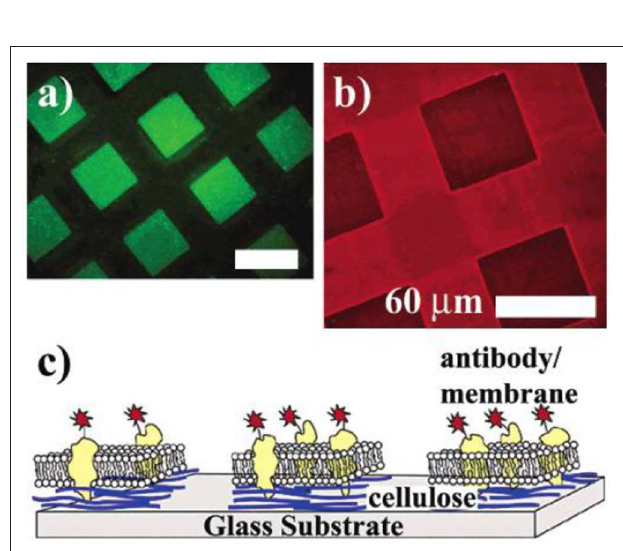
FIGURE 6 | (a) Fluorescence image of cellulose micropatterns exposed to a solution of bovine serum albumin labeled with fluorescein isothiocyanate (FITC-BSA) after removing the photomask. FITC-BSA adsorbs only onto the ablated area (bare glass substrate). (b) Human erythrocyte membranes spread on cellulose microtemplates (without BSA treatment). After incubation, the cytoplasmic domain of Band 3 is identified with a monoclonal and a TRITC-labeled polyclonal antibody (inside label). (c) Orientation of the erythrocyte membrane after spreading. Erythrocyte ghosts selectively adhere and rupture only on the cellulose micropatterns, exposing their cytoplasmic side (Reproduced from Tanaka et al., 2004 with permission from American Chemical